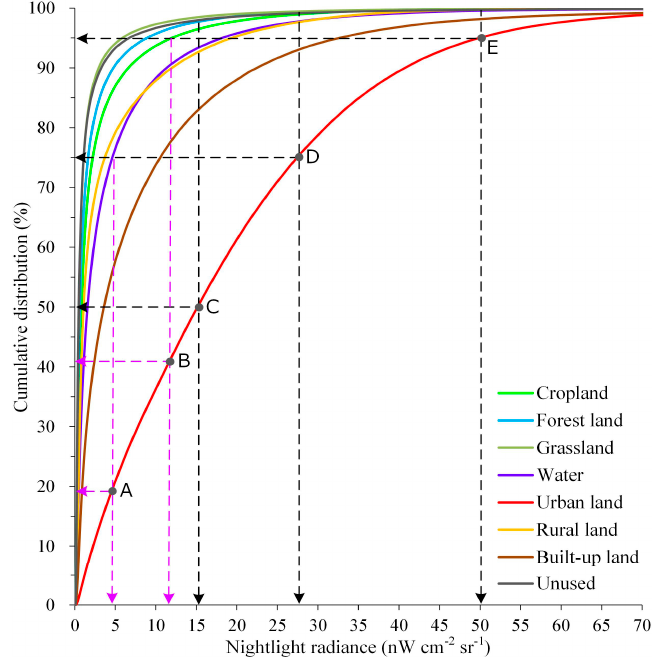
Figure 6. Cumulative distributions of pixel-level nighttime light signals for eight types of land use/land cover across China in 2015.